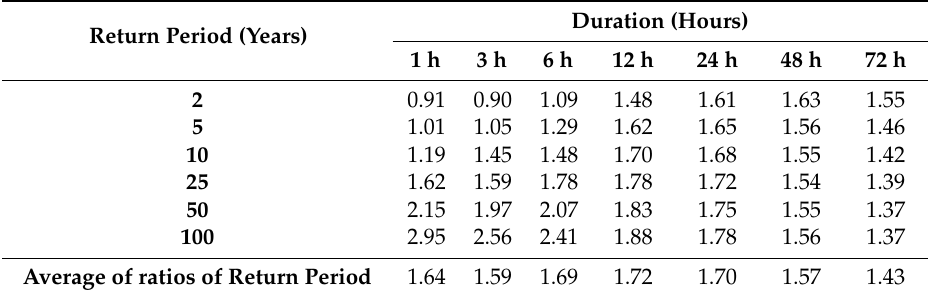
Table 6. Ratios of modelled to observed rainfall for BCC-CSM1.1 for RCP 4.5 at Kedah.